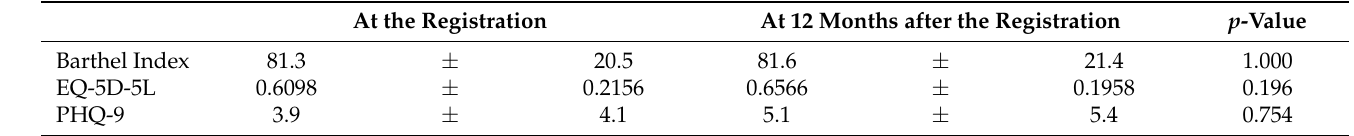
Table 4. Changes in the physical and psychological indicators of the case management